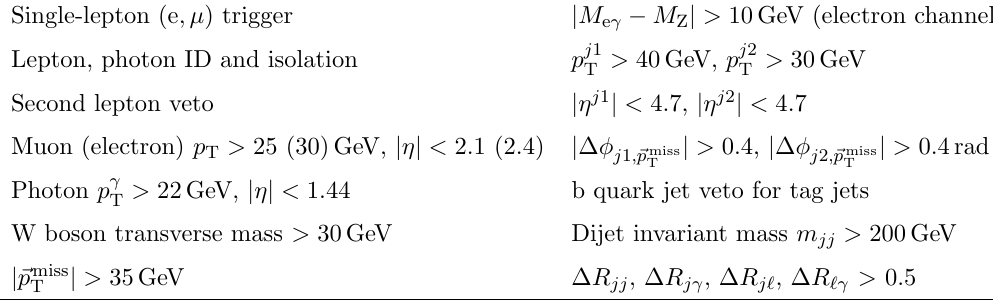
Table 1 . Summary of the baseline selection